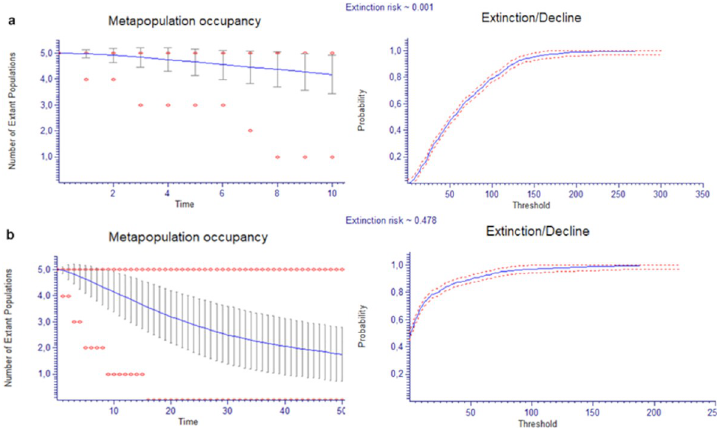
Fig 5. Population Viability Analysis of Asperula naufraga a) in the next 10 and b) in the next 50 years. The average (line), ± 1 standard deviation and minimum and maximum (dots) numbers of the population of A . naufraga are